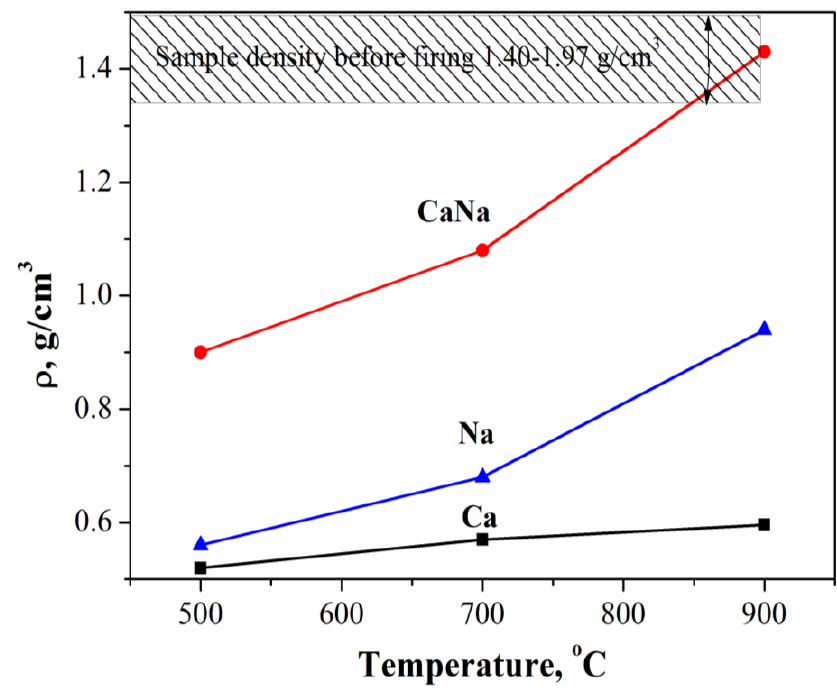
Figure 7. Density of ceramic materials, obtained by annealing of cement-salt stone in the temperature range of 500 – 900 °C.